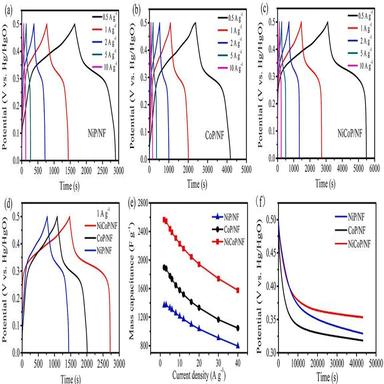
(a-c) The GCD curves of NiP/NF, CoP/NF, and NiCoP/NF at various current densities, (d) Comparison of the GCD curves at scan rate of 2 A g− 1 , (e) Specific capacitance of the NiP/NF, CoP/NF and NiCoP/NF at versus current densities, (f) The self-discharge behaviors of the NiP/NF, CoP/NF and NiCoP/NF.